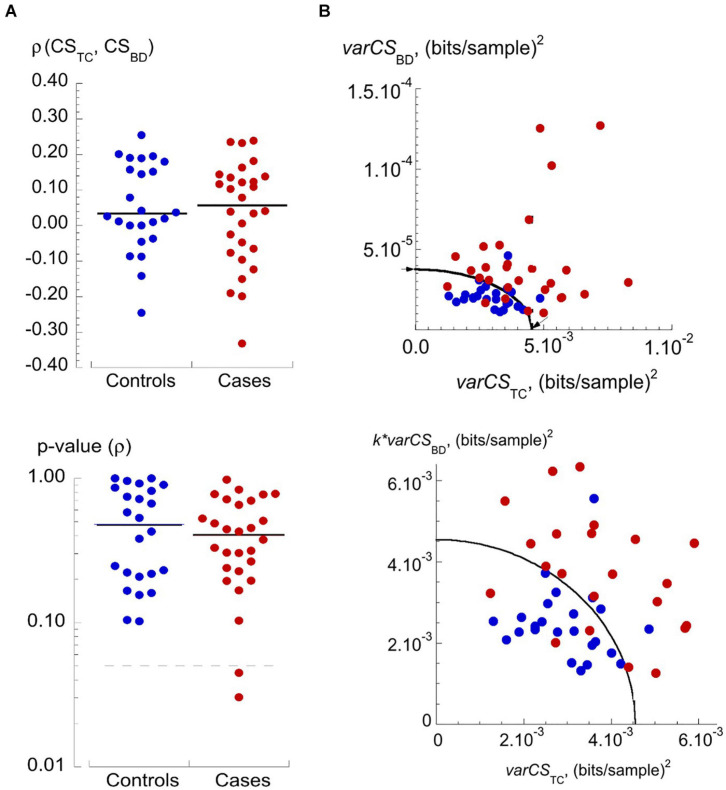
Independence of varCSTC and varCSBD and their values for controls and cases. (A) Dot plots of Spearman rank correlation coefficient, ρ, (upper) and calculated p-values (lower) of varTC-varBD relationships in the controls and cases cohorts. Lower plot: dotted line represents the p-value of 0.05; note the logarithmic ordinate scale. (B) Upper: plot of varCSBD vs varCSTC values for controls (blue circles) and cases (red circles). The curve is an ellipse that optimally separates data from controls and cases cohorts, arrows mark the intercepts with axes, used to estimate a scaling factor for the varCSBD data – see text for details. Lower plot: transformed data where the varCSBD data are multiplied by a constant, k, to allow a circle function to optimally separate data from controls and cases cohorts – see text for details.